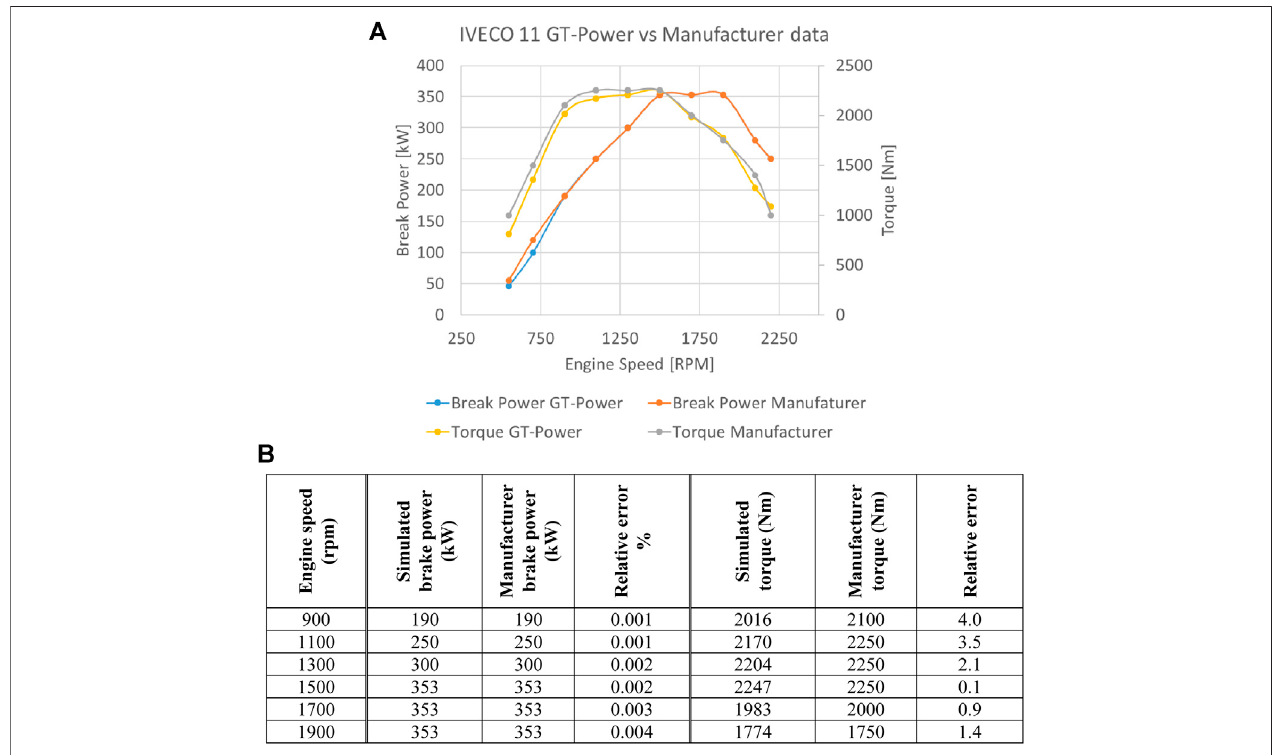
FIGURE 10 | (A) Power and torque curves simulated on GT-Power and provided by the manufacturer and (B) power and torque values simulated on GT-Power and provided by the manufacturer.